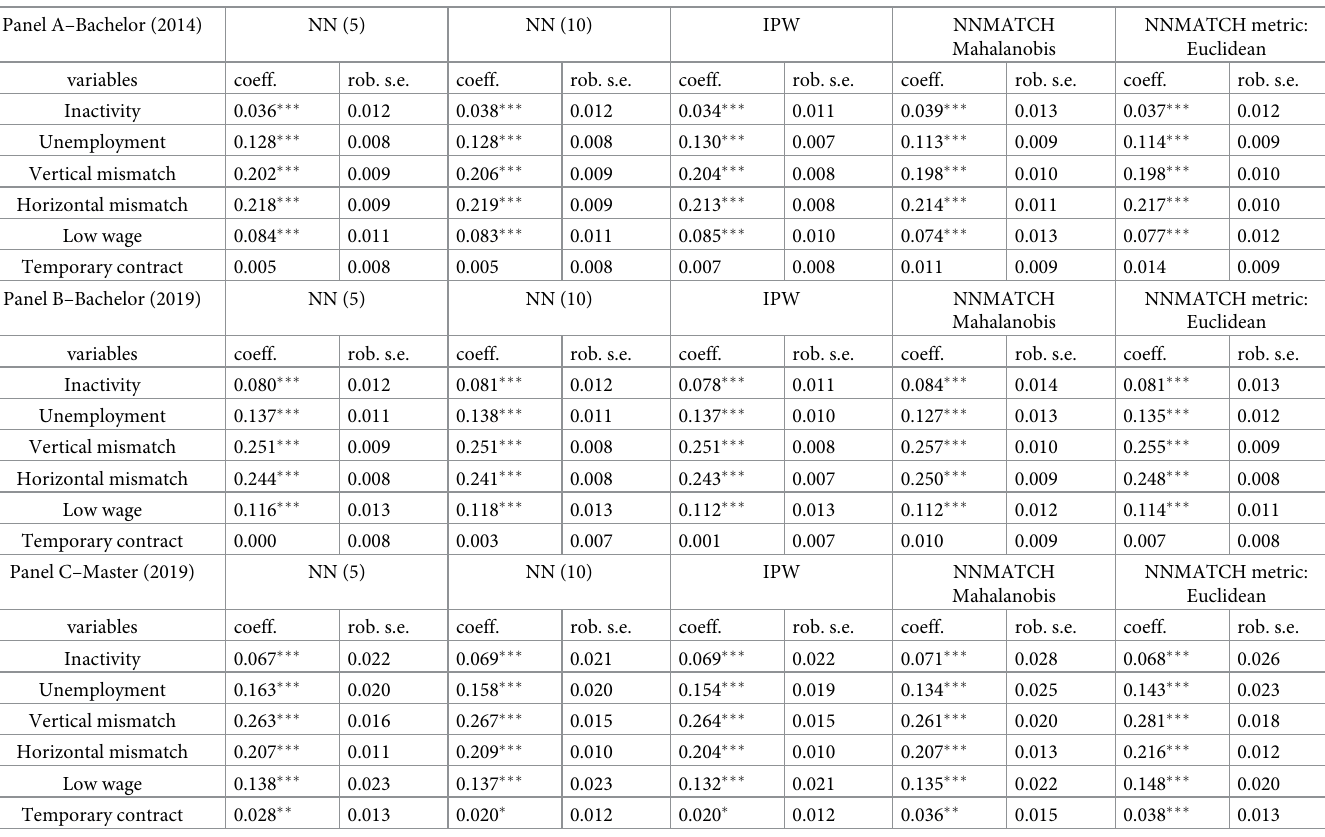
Table 7. Estimates of the association between job placement results and graduate dissatisfaction with different matching algorithms or TE